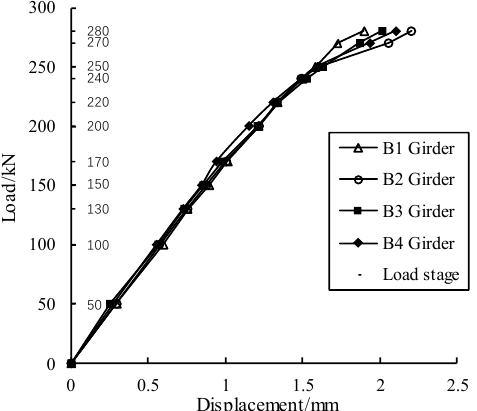
Table 1. Maximum deformation test values of girder specimens (unit: mm).